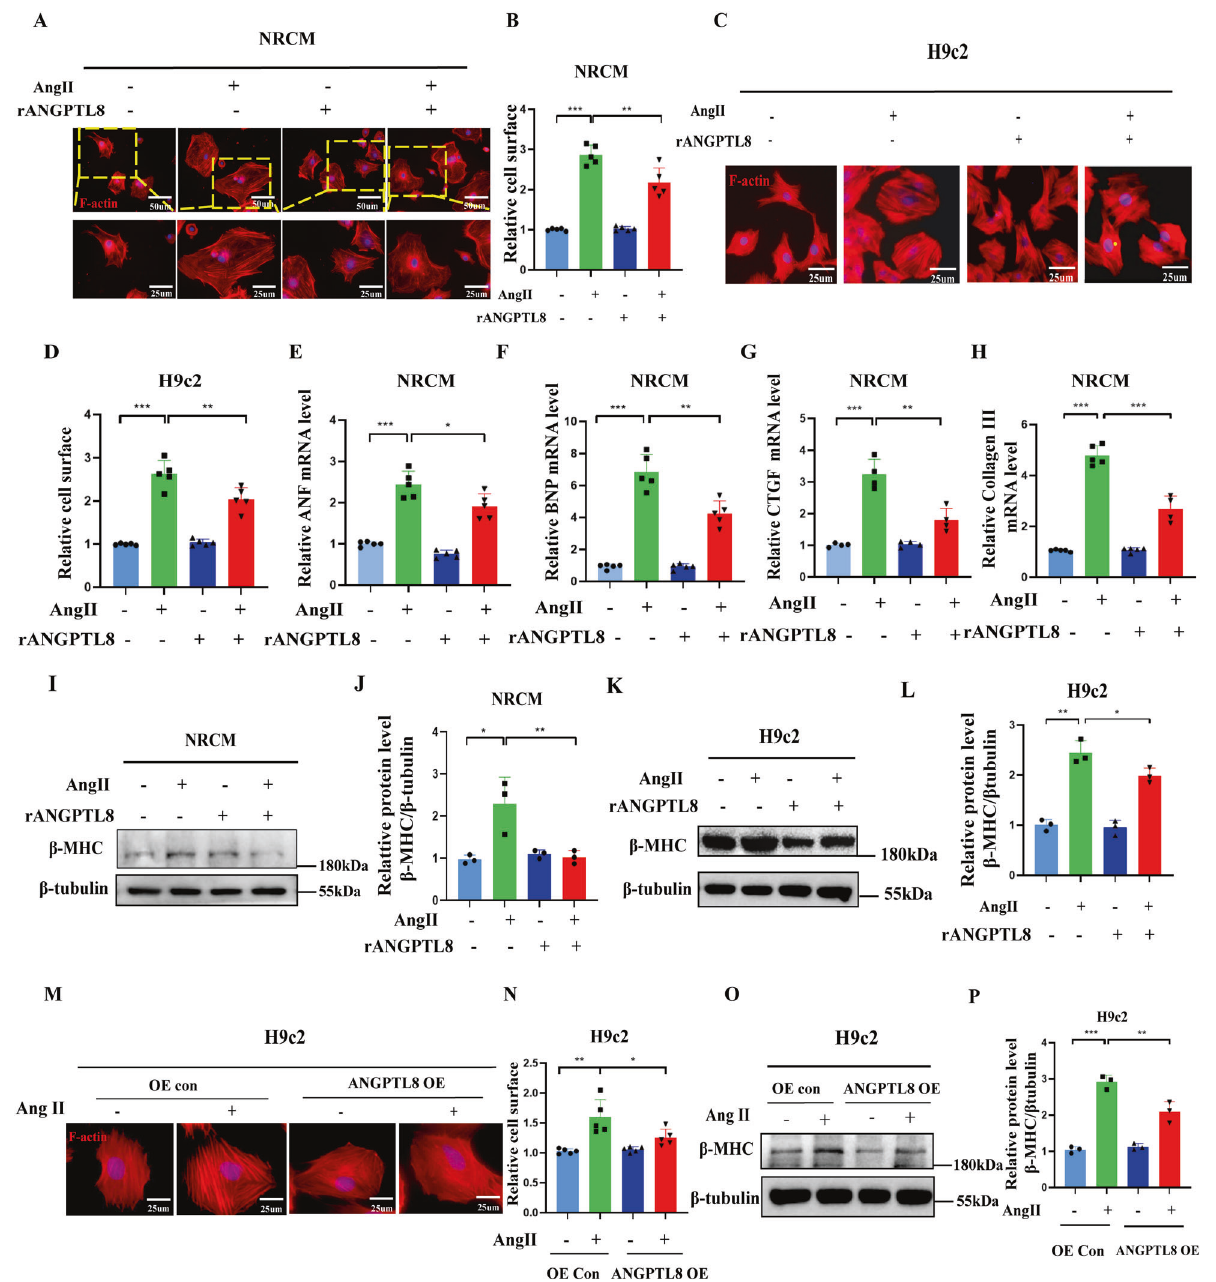
Fig. 4 ANGPTL8 ameliorated cardiomyocyte hypertrophy induced by Ang II in vitro. Primary NRCM or H9c2 cells were treated with recombinant human full-length ANGPTL8 protein (rANGPTL8, 500 ng/ml) and Ang II (1 µM) for 48 h. A Representative microscopic images of NRCMs stained with rhodamine phalloidin in the indicated groups (scale bar, 50 μ m and 25 μ m, respectively). B Quantitative results of the cell surface area of cardiomyocytes in the indicated groups ( n > 50 cells per group, 5 independent experiments, ** P < 0.01, *** P < 0.001). C Representative microscopic images of H9c2 cells in the indicated groups (scale bar, 25 μ m). D Quantitative results of the cell surface area of H9c2 cells in the indicated groups ( n > 50 cells per group, 5 independent experiments, ** P < 0.01, *** P < 0.001). E – H Quanti fi cation of the mRNA levels of ANF, BNP, collagen III and CTGF in NRCM in the indicated groups ( n = 5 per group, ** P < 0.01, *** P < 0.001). I – L Representative western blots and quanti fi cation of β -MHC in NRCM and H9c2 cells in the indicated groups ( n = 3 per group, * P < 0.05, ** P < 0.01). H9c2 cells were infected with the indicated lentivirus of ANGPTL8 for 24 h and then treated with Ang II (1 µM) for 48 h. M , N Representative microscopic images and quantitative results of the cell surface area of H9c2 cells in the indicated groups ( n > 50 cells per group, 5 independent experiments, scale bar, 25 μ m). O , P Representative Western blots and quanti fi cation of H9c2 cells in the indicated groups ( n = 3 per group). (OE overexpression *P < 0.05, ** P < 0.01, *** P <